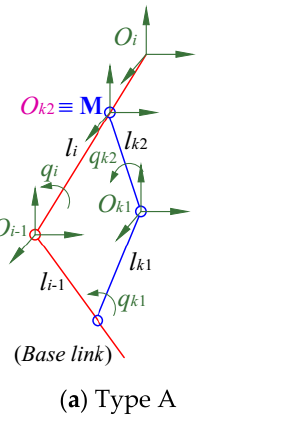
Figure 4. The closed kinematic chain of the local linkages.